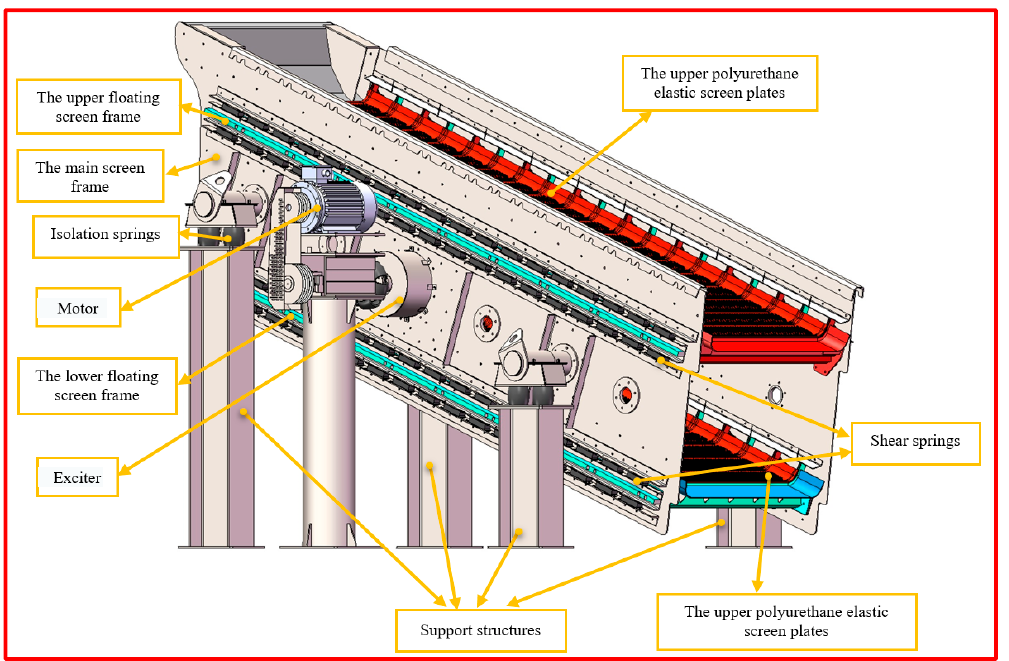
Figure 2. Schematic diagram of double-deck vibrating flip-flow screen structure.